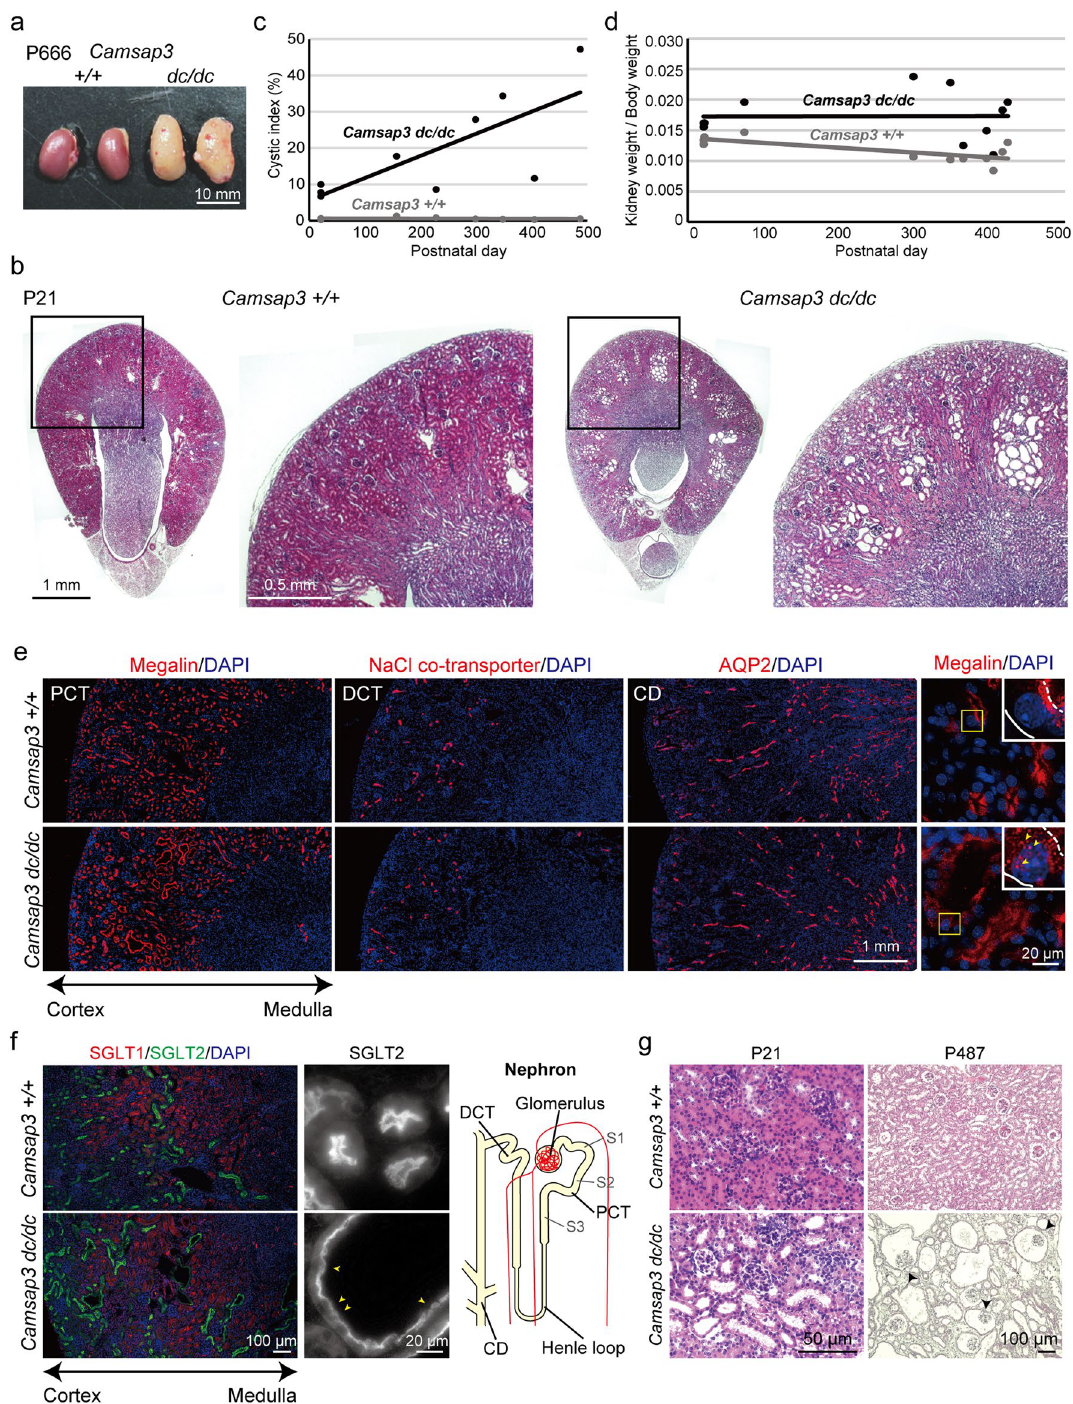
Figure 1. Cyst formation in proximal convoluted tubules of Camsap3 dc/dc kidneys. ( a ) Morphology of kidneys of WT (+ / +) and Camsap3 mutant ( Camsap3 dc/dc ) mice at P666. ( b ) H&E staining of WT and Camsap3 dc/dc kidneys at P21. Multiple cysts formed in the cortex of Camsap3 dc/dc kidneys. ( c ) Change of cystic index of WT and Camsap3 dc/dc mice over time. 9 mice were examined for WT or Camsap3 dc/dc . See the MATERIALS AND METHODS for the definition of cystic index. ( d ) Ratio of kidney to body weight. 11 mice were examined for WT or Camsap3 dc/dc . ( e ) Immunostaining for markers of proximal convoluted tubules (PCT) (Megalin), distal convoluted tubules (DCT), NaCl co-transporter, and collecting ducts (CD) (aquaporin-2; AQP2) in WT and Camsap3 dc/dc kidneys at P21. Images of the magnified view of Megalin show delocalized Megalin in cystic cells in Camsap3 dc/dc kidneys, as indicated by the arrowhead. Broken and continuous lines indicate the apical and basal margin of the cell, respectively. ( f ) Immunostaining for markers of the S1/S2 segments (SGLT2, green) and S3 segment (SGLT1, red) in WT and Camsap3 dc/dc kidneys at P21. Images of the magnified view of SGLT2 show decreased SGLT2 signal intensity in cystic cells in Camsap3 dc/dc kidneys, as indicated by arrowheads. ( g ) Morphology of the glomerulus at P21 and P487. Arrowheads indicate the dilated glomerulus. See also Figures S1 and